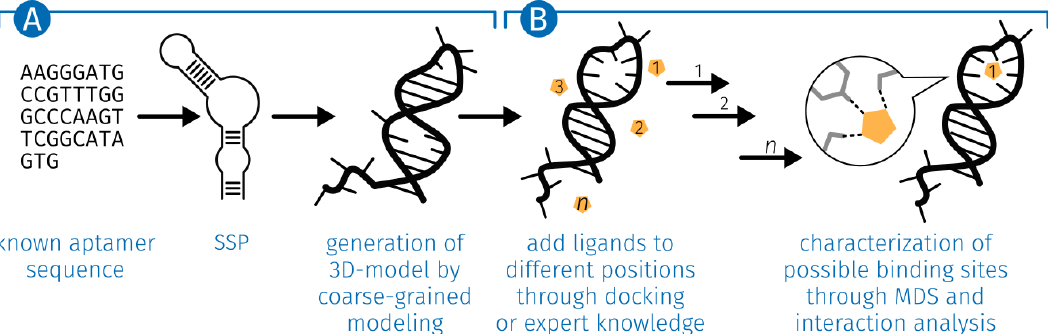
Figure 11. Schematic overview of the developed workflow for detailed analysis of ligand-aptamer interactions. ( A ) Starting from a known ligand-specific aptamer sequence and the prediction of the secondary structure, the 3D structure is modeled. ( B ) The modeled 3D structure is the basis for the MD simulation. First, the ligand is integrated within the structure through docking or expert knowledge. After the MD simulation, the resulting structures of the individual time steps are examined for possible binding sites and the interactions formed are detected. MDS, molecular dynamics simulation; SSP, secondary structure